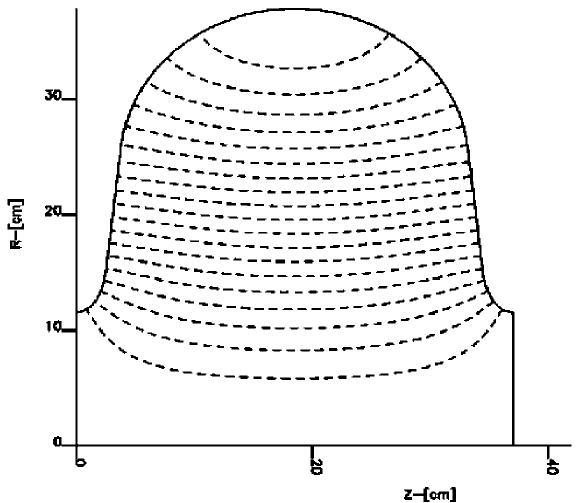
FIG. 2. Electric field lines for the TE Graphical output by OSCAR2D .